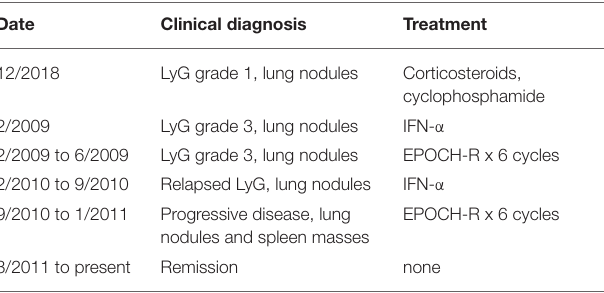
TABLE 1 | Clinical diagnosis and treatment of the